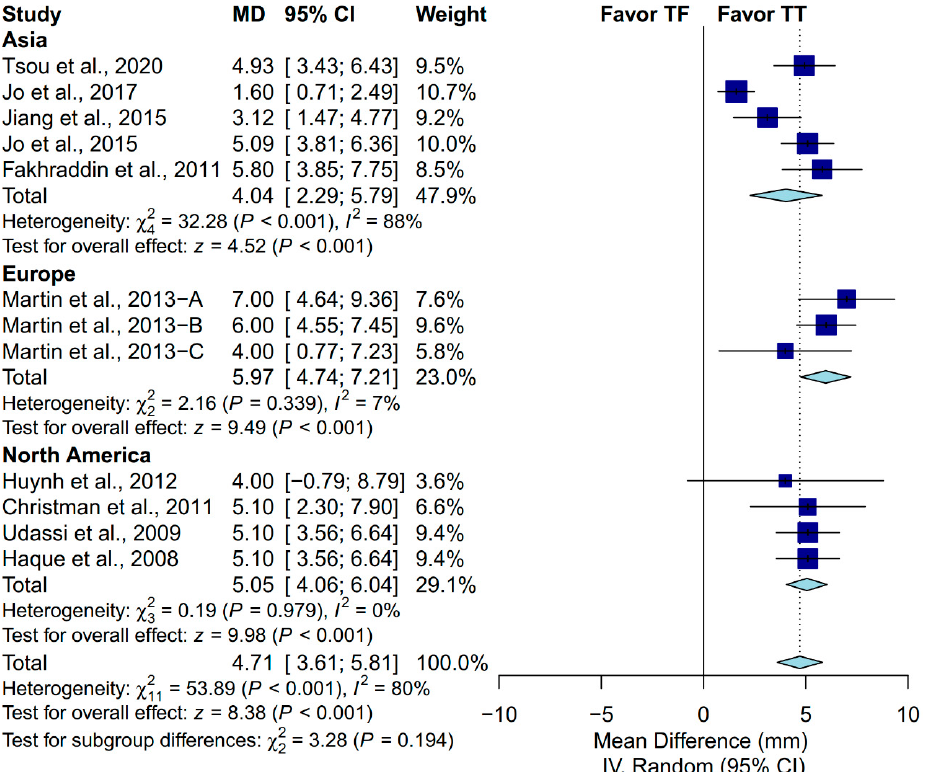
Figure 8. Subgroup analysis of chest-compression depth grouped by participant expertise.